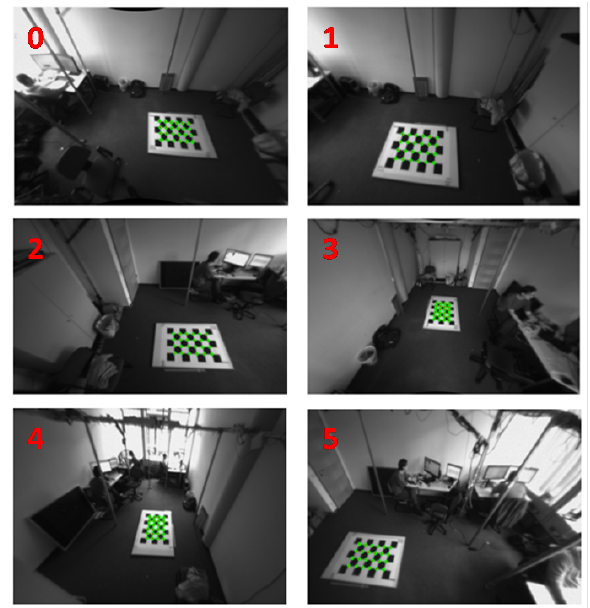
Figure 7: Corrected chessboard points after applying bundle ad- justment to all six stereo cameras